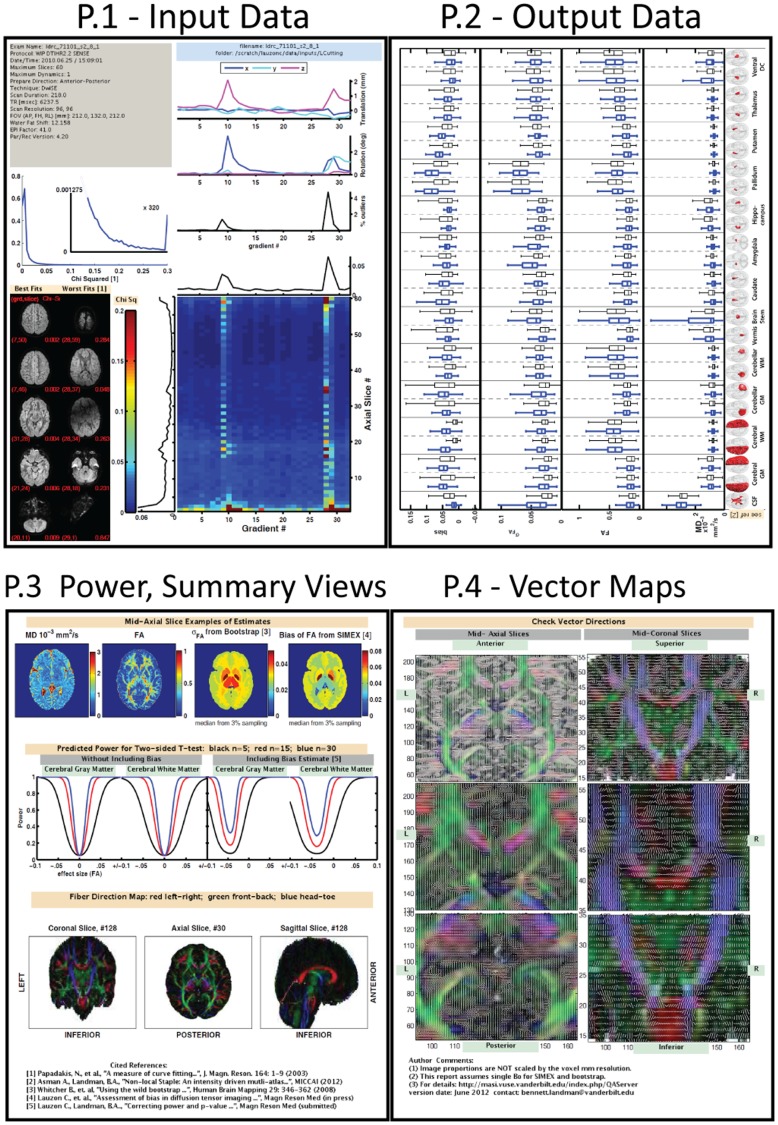
The four pages of the QA report.All data is shown from the same subject. The first page (P.1) parses the header (gray and blue boxes), plots patient movement in rotation and translation, plots RESTORE outliers per DWI (three upper right plots), plots  (color plot), shows five ‘best’ and ‘worst’ DWI slices (bottom left), and plots a histogram of  with an automatically determined magnification around the ‘noise’ lobe region as described in Papadakis et. al.. (P.2) shows a model of the 25 segmented regions (right column) and plots regional distributions of MD, FA, , and B
FA (blue boxplots) adjacent to corresponding distributions from the Multi-modal dataset (black boxplots). (P.3) Page three displays mid-axial slice views for MD, FA,, and B
FA (top row, left to right), select power curves for FA (middle column), and full mid coronal, axial, and sagittal slices for the vector colormap (R = right-left, G = anterior-posterior, B = foot-head). (P.4) Page 4 shows the vector directions (while lines, not clearly discernible at figure size) overlaid on the vector colormap for a mid-axial (left column) and mid-coronal (right column) slice. Three different enlargements are shown for improved viewing.